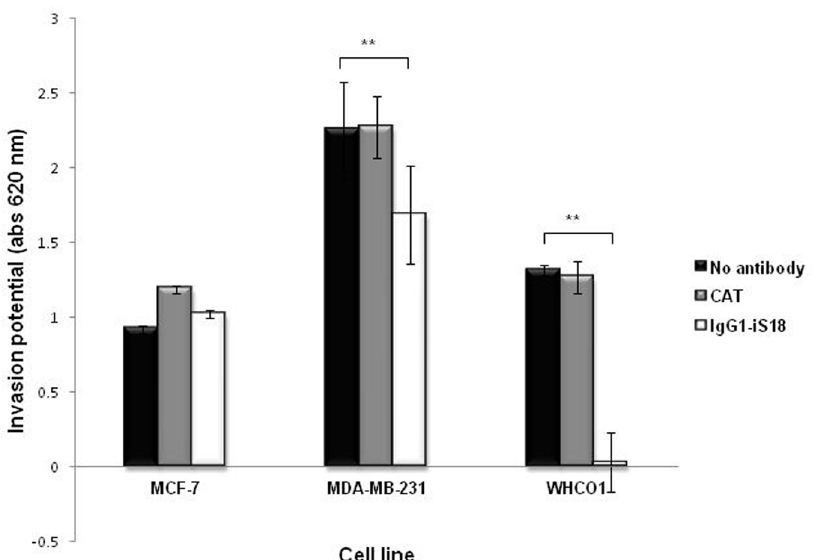
Figure 5. Effect of anti-LRP/LR specific antibody IgG1-iS18 on the invasive potential of breast and oesophageal cancer cells. Cells were incubated with IgG1-iS18 (0.2 mg/ml) or CAT (negative control) (0.2 mg/ml) on Matrigel TM coated inserts for an 18 h period. Toulidine blue was used to stain the invaded cells and following extraction of the dye using SDS absorbance was measured at 620 nm. A significant decrease in invasion potential was noted for both WHCO1 and MDA-MB 231 cells upon application of IgG1-iS18 antibody (light gray) compared to the no antibody control (black). Data are representative of three experiments carried out in triplicate from different cell cultures.